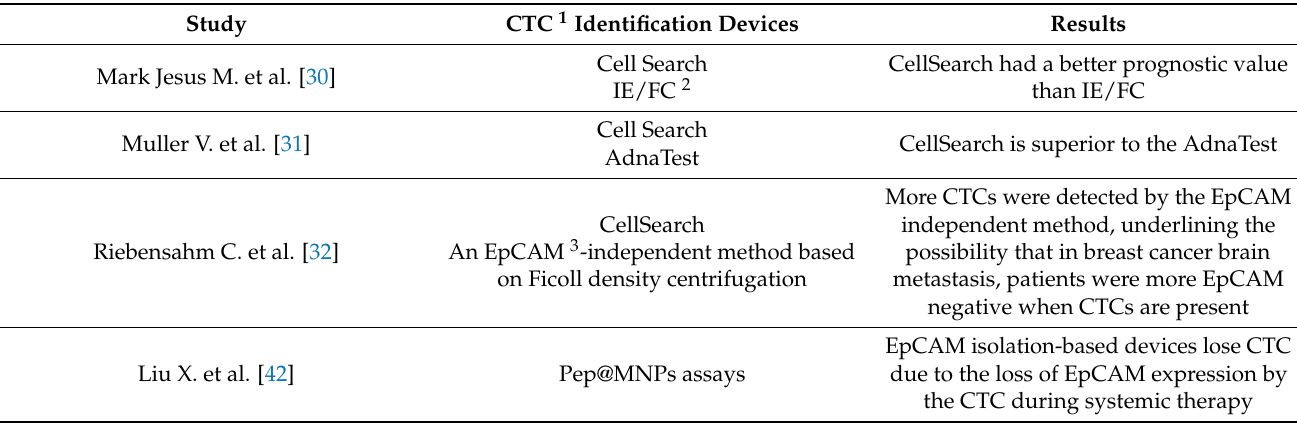
Table 4. Studies that analyze CTC 1 identification